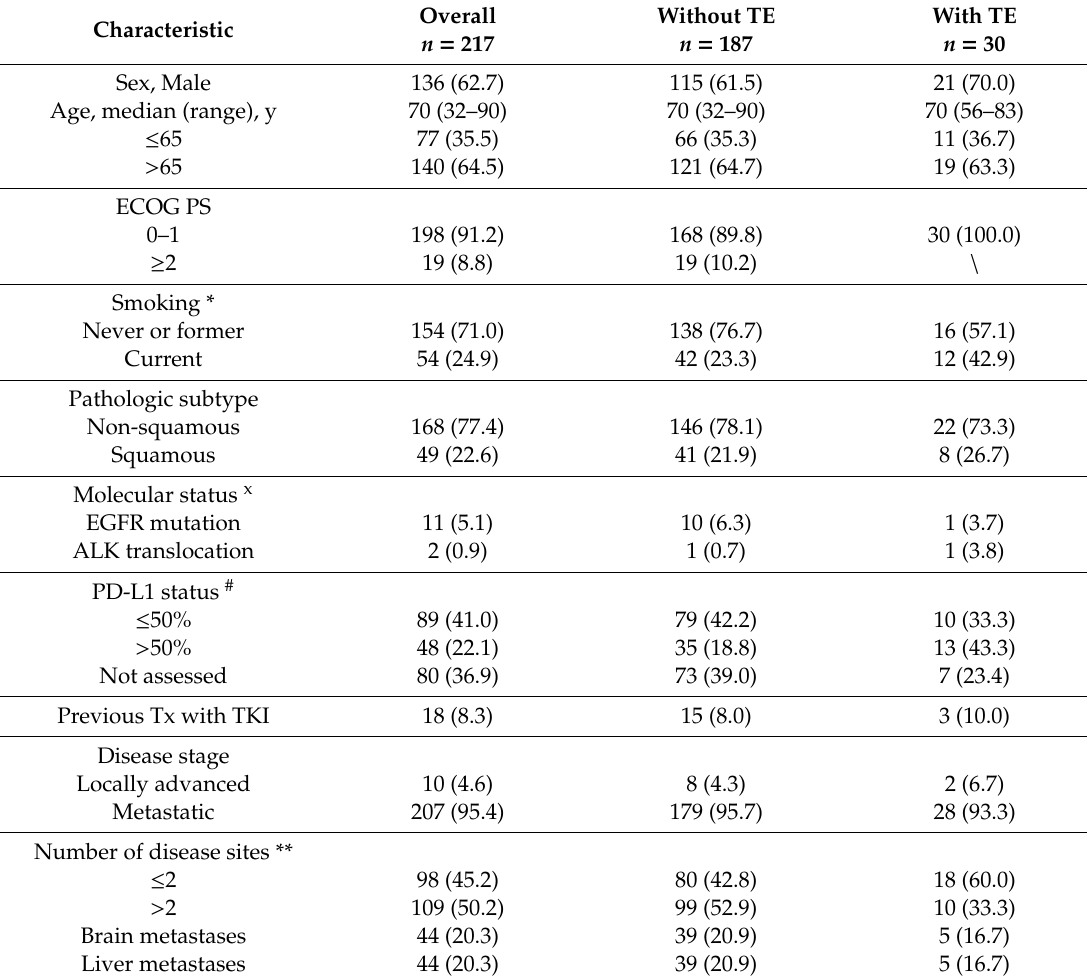
Table 1. Baseline patients’ characteristics in the whole case series and according to the presence or absence of TE